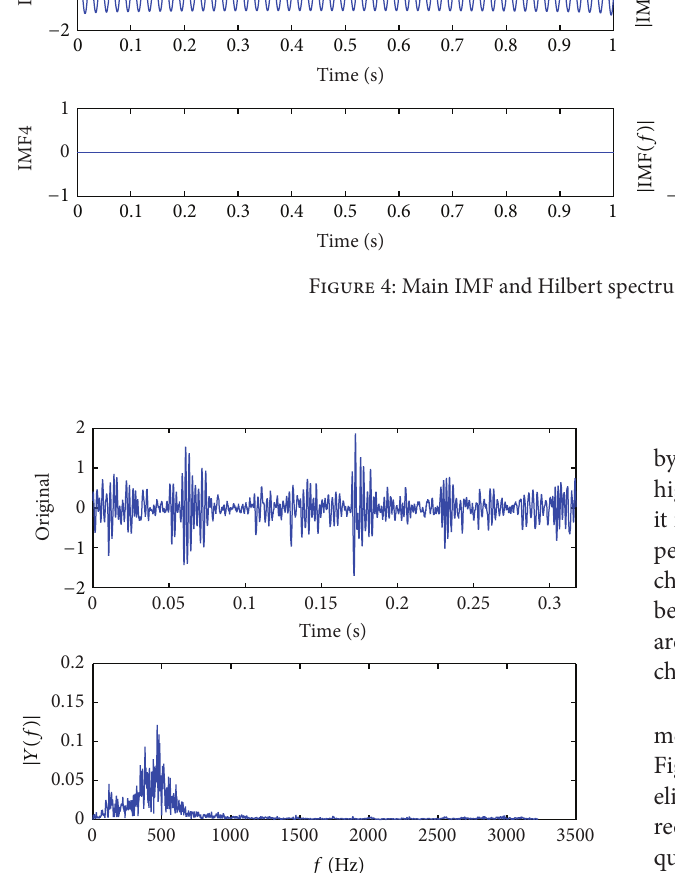
Figure 5: Time-domain signals of gearbox and description of gearbox signal